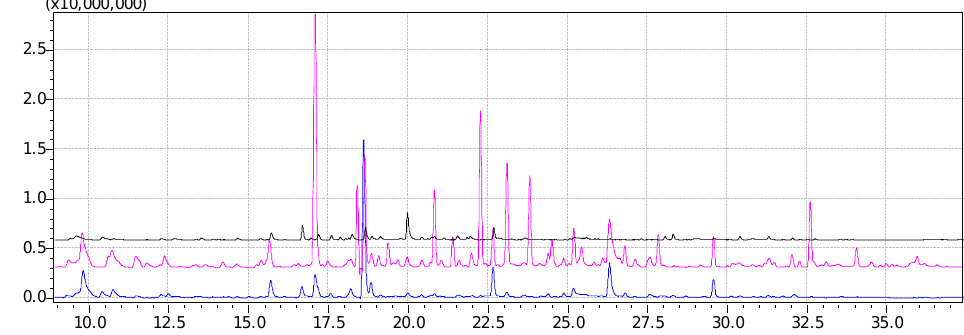
Figure 1. Chromatograms of traditional honey aroma compounds (black line — rape honey, pink line — lime honey, blue line — meadow and marsh honey) .